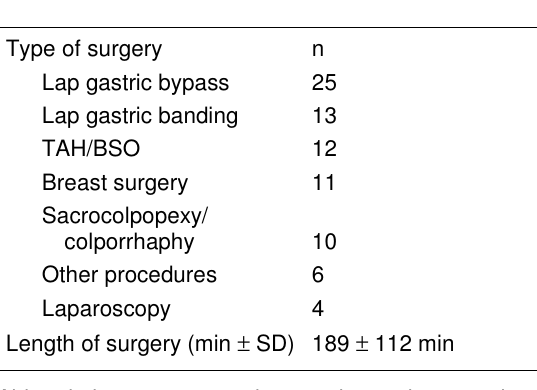
Anesthetic and Surgical